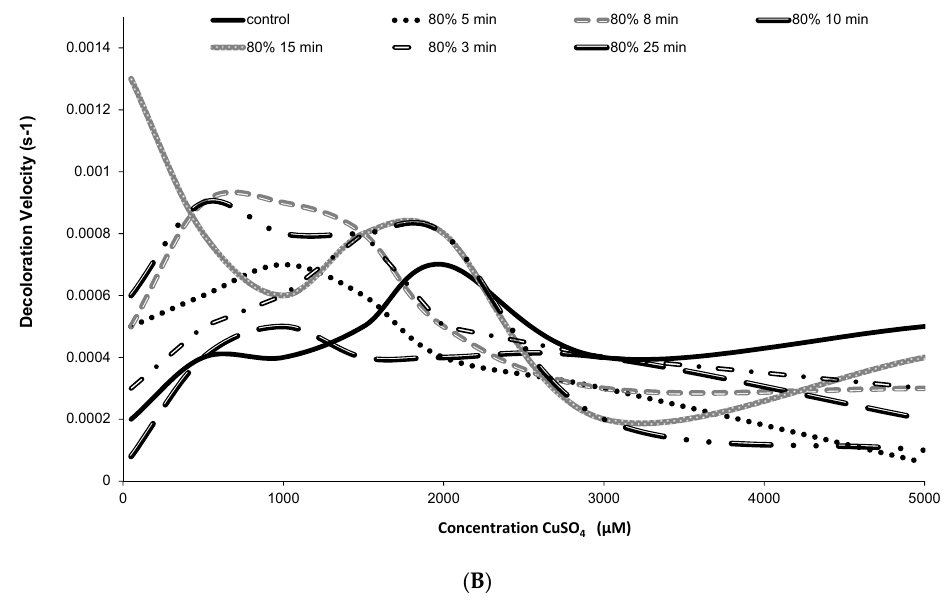
Figure 3. Bleaching speed of betacyanins in purple cactus pear juices treated by ultrasound at ( A ) amplitude of 40%, 60%, and 80% and ( B ) control sample at different times and CuSO 4 concentrations.